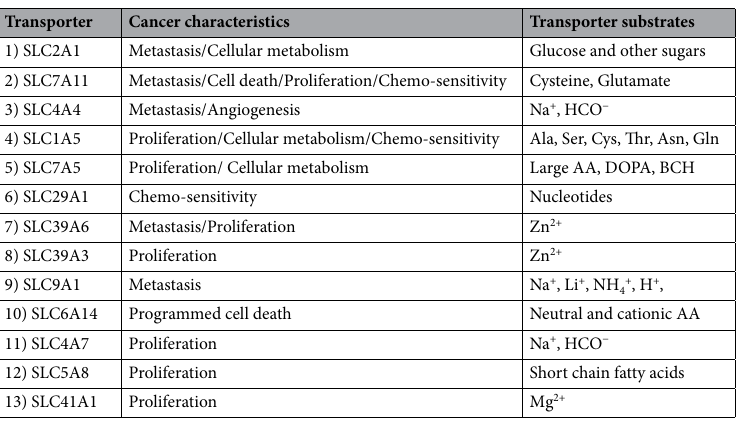
Table 1. The solute carrier transporters relevant in pancreatic cancer. The Table 1 is summarized from Wu et al. (Ref 1 ). For details, please consult the original